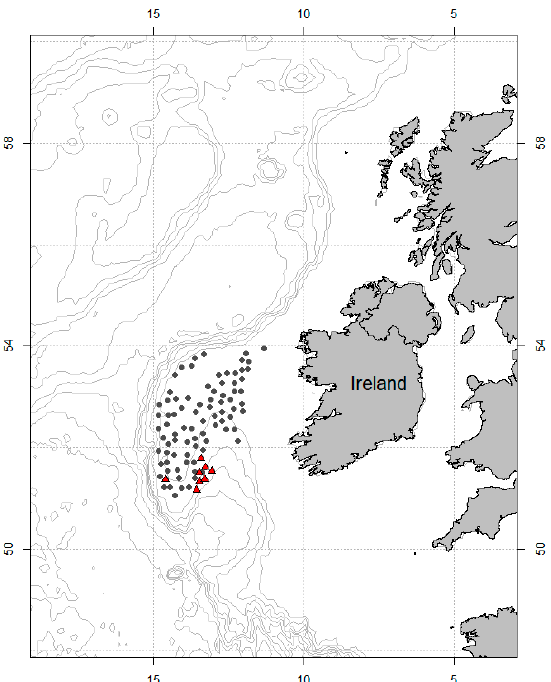
Figure 1. Map showing the bottom trawls (grey dots) conducted during the science cruise on the Porcupine Bank. The red triangle marks represent the locations where the analyzed specimens were collected.